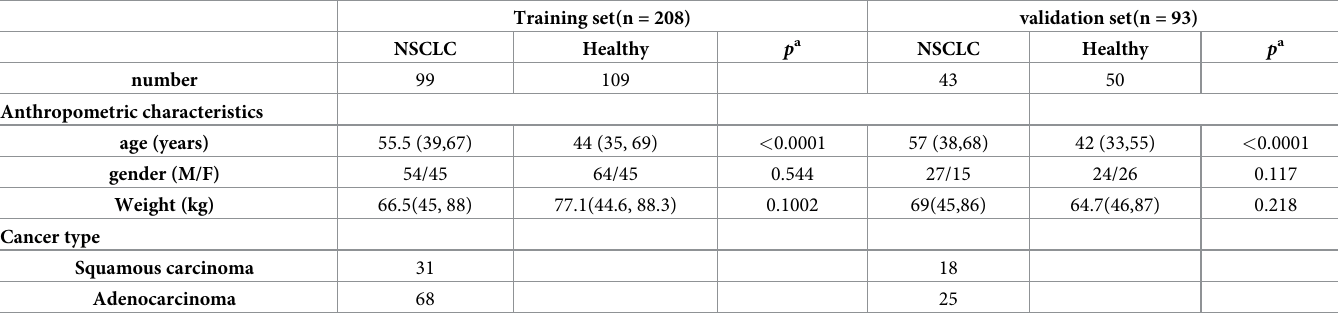
Table 1. Characteristics of the metabolomics study